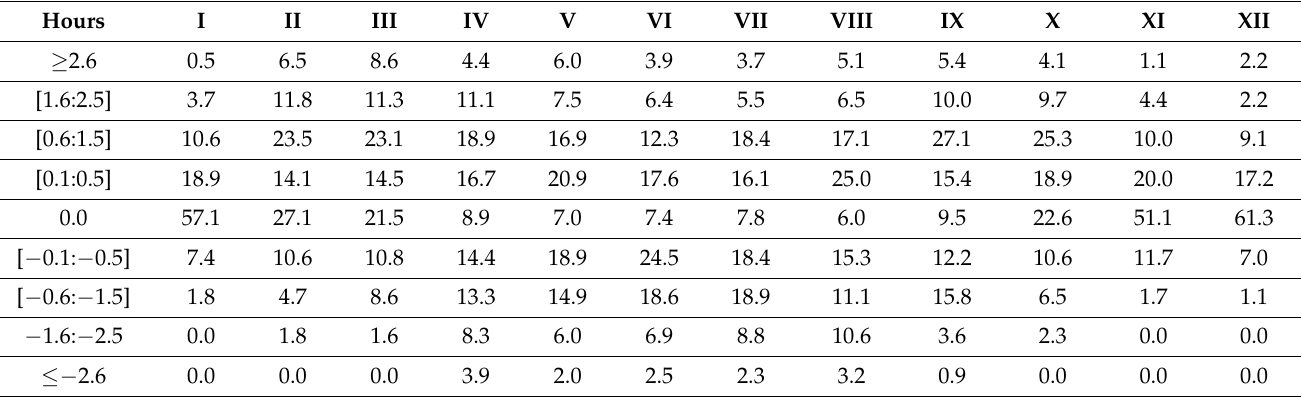
Table 1. Monthly frequency of daily differences in sunshine duration from manual and automatic measurements in Borucino, 2015–2021.